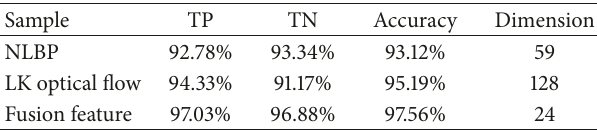
Table 4: Compared the fusion algorithm of this experiment to NLBP and LK optical flow.